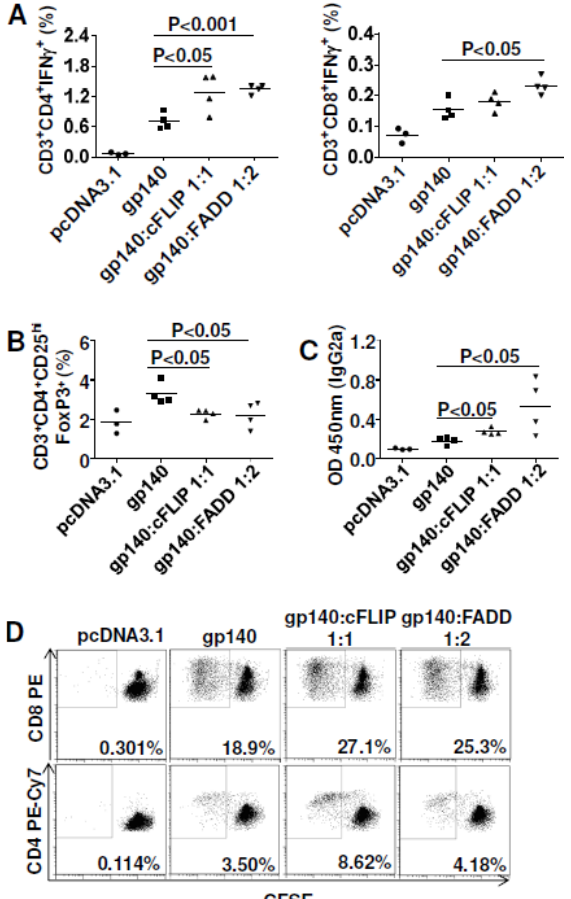
Figure 5. Cellular FLICE-inhibitory protein (cFLIP; FLICE is FADD-like IL-1beta converting enzyme) and FADD co-delivery improved both cellular immune responses and humoral immune responses for HIV gp140. C57BL/6 mice were immunized with 10 μg plasmid pcDNA3.1-gp140 combined with 10 μg plasmid pJ603-cFLIP or 20 μg